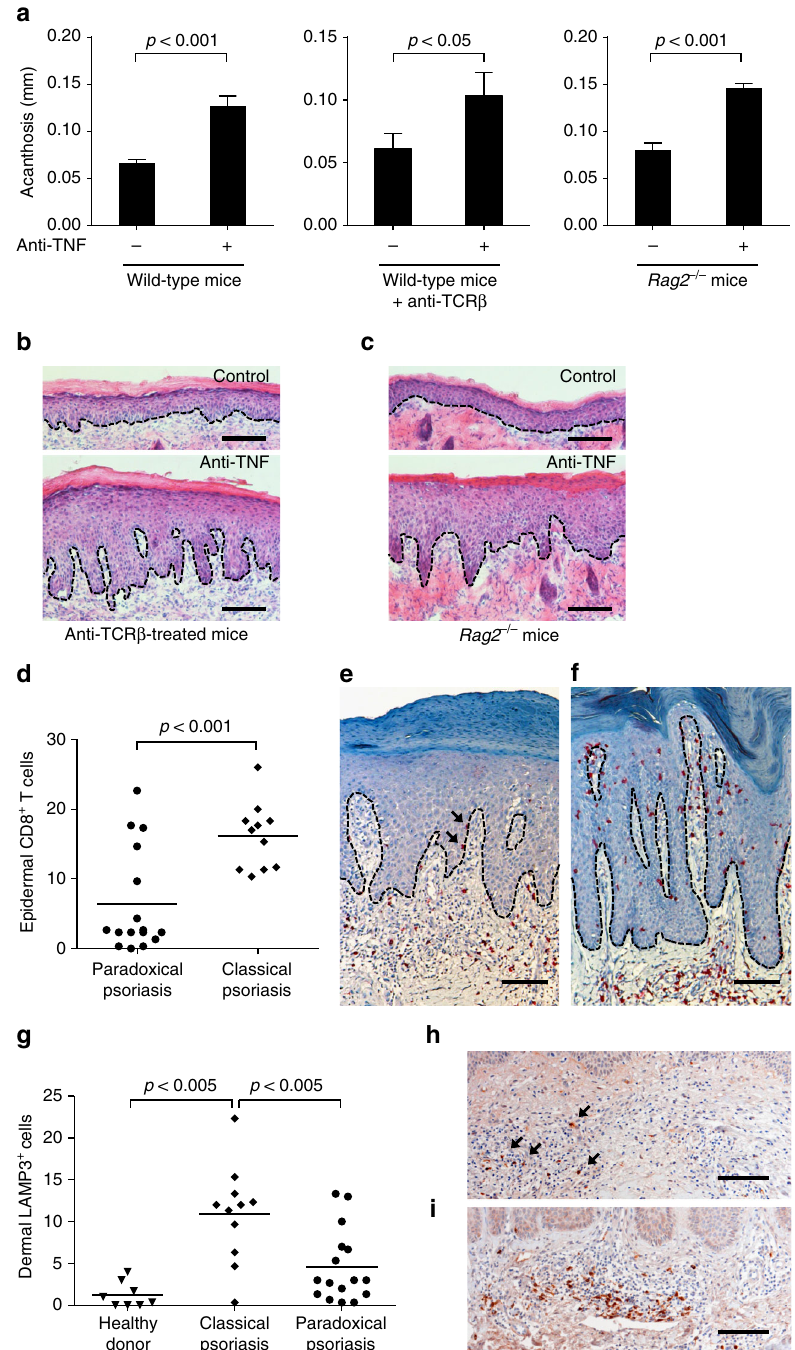
Fig. 6 T-cell-independent induction of paradoxical psoriasis. a Quanti fi cation of acanthosis 7 days after mechanical injury of wild-type mice, wild-type mice treated with anti-TCR β antibody, and Rag2 − / − mice, all of which were treated with or without anti-TNF antibody. b Representative HE staining of skin 7 days after mechanical injury of mice treated with anti-TCR β antibody alone or anti-TCR β and anti-TNF antibodies combined. c Representative HE staining of skin 7 days after mechanical injury of Rag2 − / − mice treated with or without anti-TNF antibody. d Number of epidermal CD8 + T cells per high-power fi eld in skin lesions of patients with classical psoriasis and paradoxical psoriasis. e , f Representative CD8 staining of paradoxical psoriasis ( e ) and classical psoriasis ( f ). g Number of dermal LAMP3 + cells per high-power fi eld in skin of healthy donors as well as in skin lesions of patients with classical psoriasis and paradoxical psoriasis. h , i Representative LAMP3-staining of paradoxical psoriasis ( h ) and classical psoriasis ( i ). Experiment depicted (in a – c ) is representative for two independent experiments. Bar charts in a show mean values plus SEM of fi ve mice each group. Dashed line in b , c , e , f , h , and i represents border between epidermis above and dermis below. Arrows point at intraepidermal CD8 + T cells in paradoxical psoriasis ( e ) or dermal LAMP3 + cells ( h ), respectively. All statistical analyses were performed with unpaired Student ’ s t -test. Anti-TCR β = anti-T-cell receptor beta chain